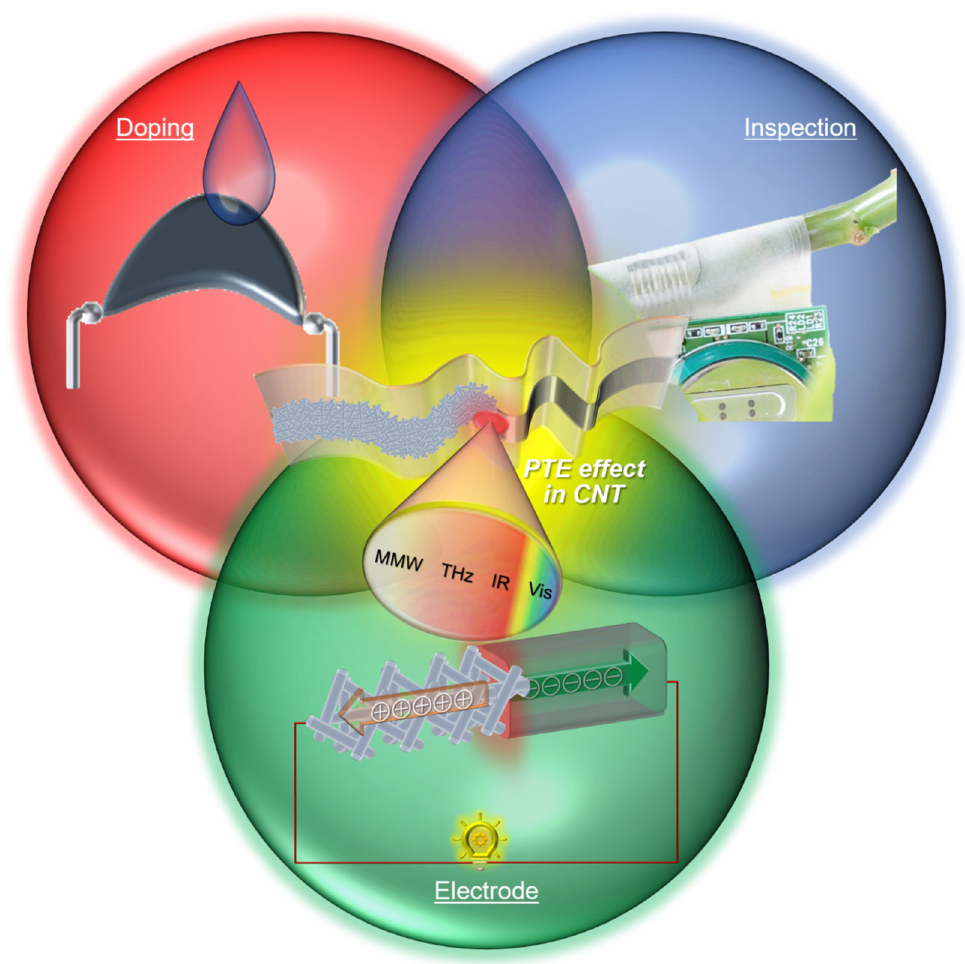
Figure 1. Conceptual diagram of developing the CNT-film-based PTE sensors. Reproduced with permission from [24] Copyright 2021, the authors, published by Wiley-VCH. Reproduced with permission from [25] Copyright 2021, the authors, published by Springer Nature. Reproduced with permission from [26] Copyright 2022, the authors, published by American Association for the Advancement of Science.